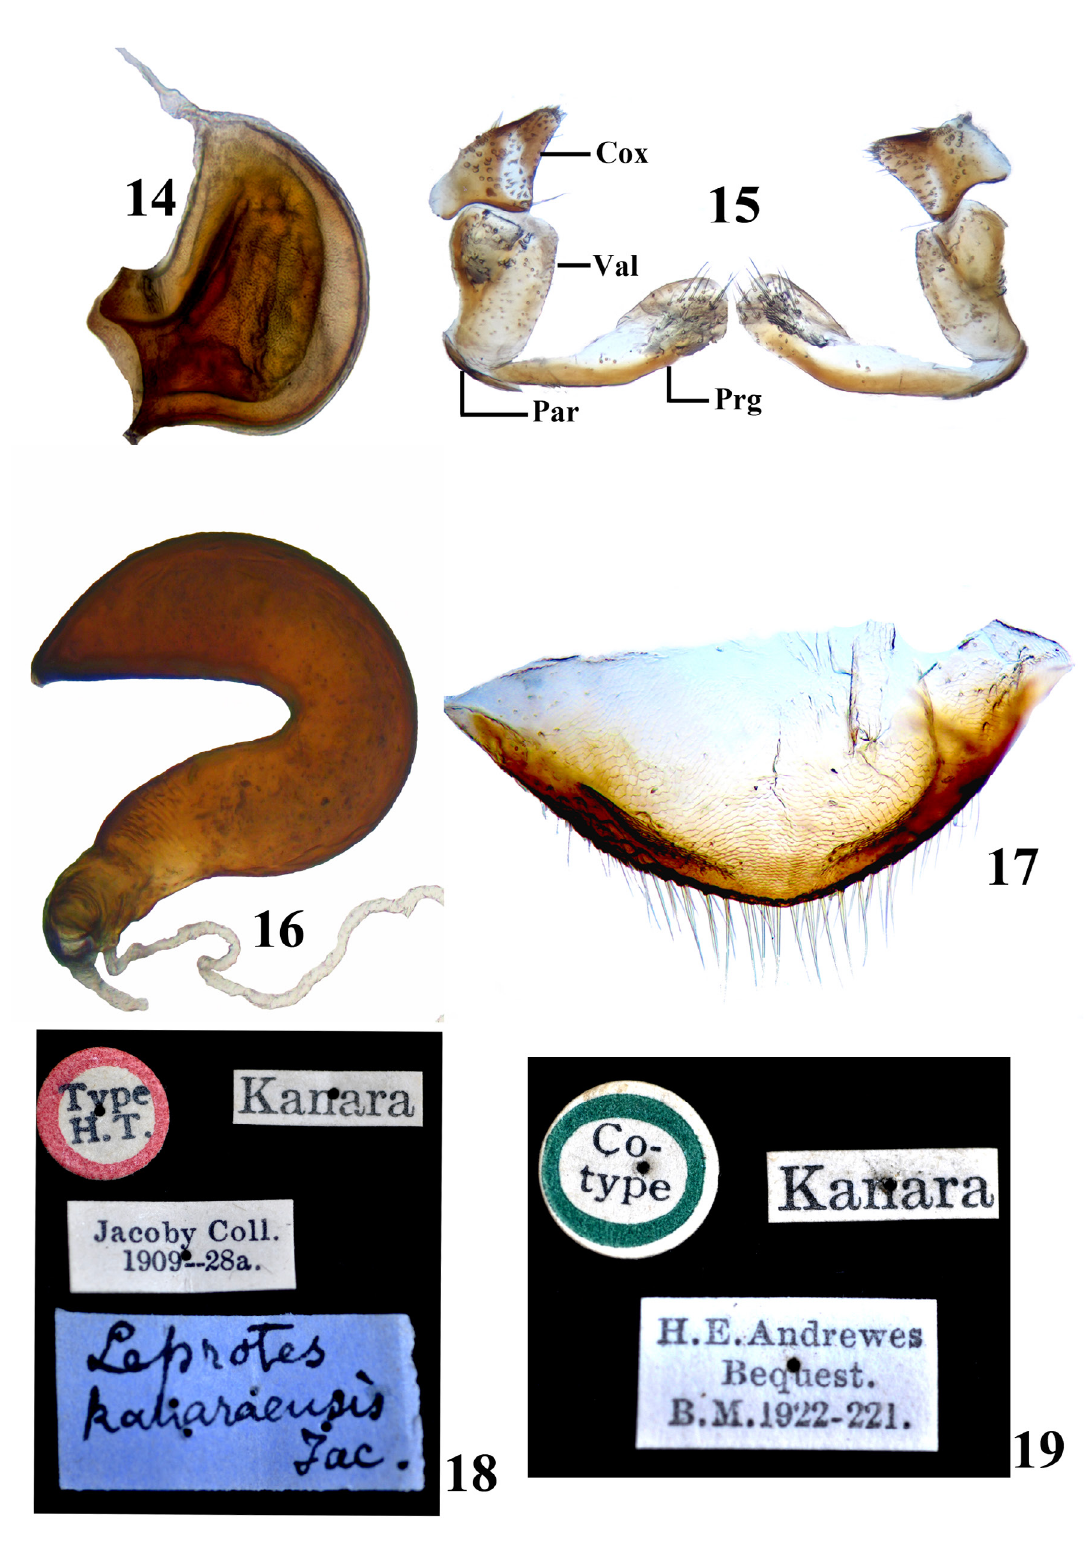
Figs 14–19. Close up of parts of female genitalia of Fidia kanaraensis (Jacoby, 1895) comb. nov. 14 . Bursa copulatrix. 15 . ovipositor. 16 . Spermatheca. 17 . Eighth tergite. 18 . holotype labels. 19 . Paratype labels. Abbreviations: Cox = coxite; Par = paraproct; Prg = proctiger; Val =